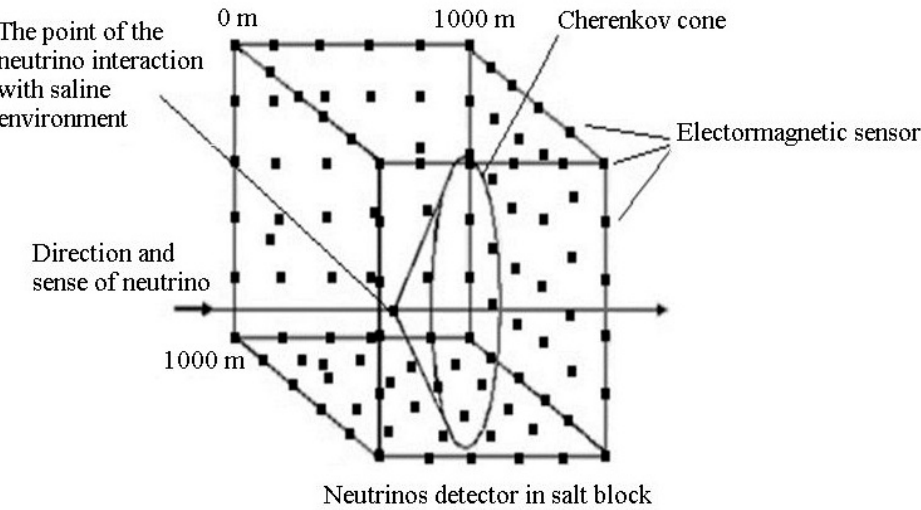
Figure 1. Neutrinos detector in a salt block consisting of electromagnetic sensors placed in a cube with a 1 km side [23].